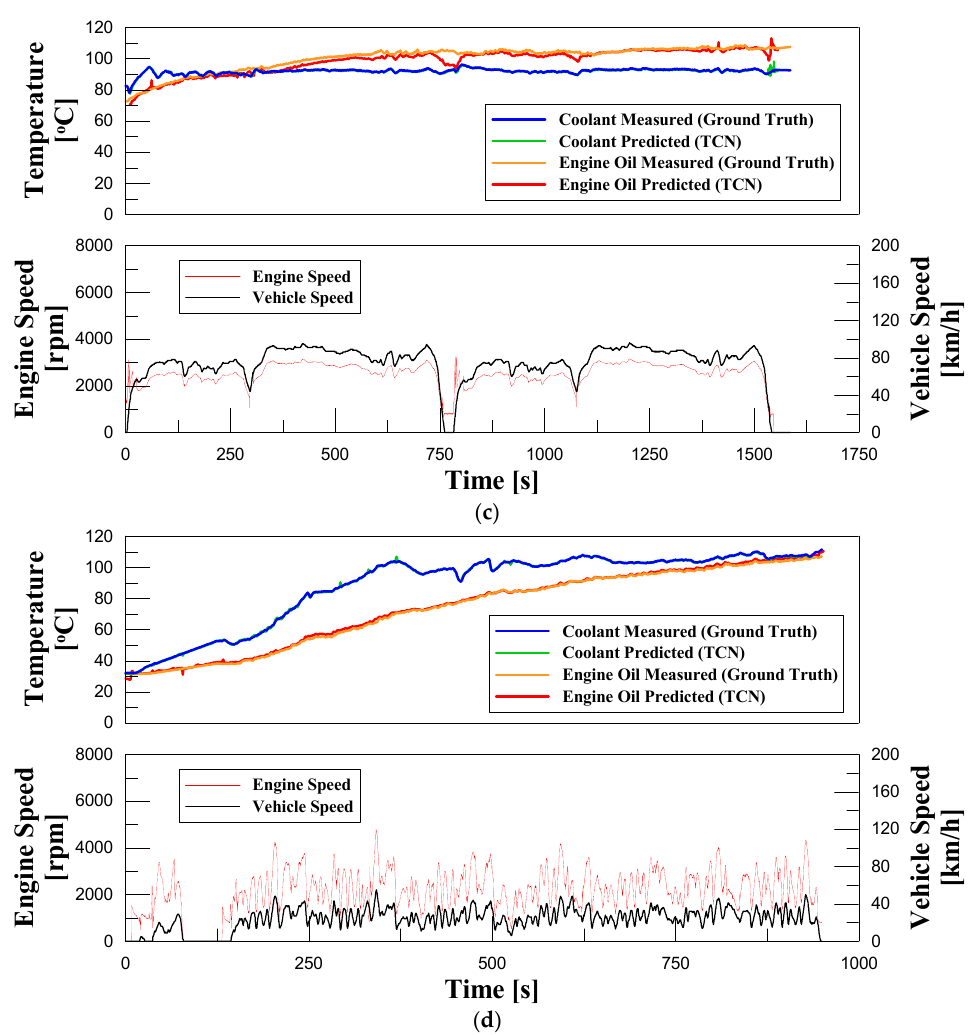
Figure 11. Neural network method (TCN) prediction of coolant and engine oil temperature and comparison of actual measurements. ( a ) FTP-75 Phase 1,2; ( b ) WLTC; ( c ) HWFET; ( d ) On-road test.